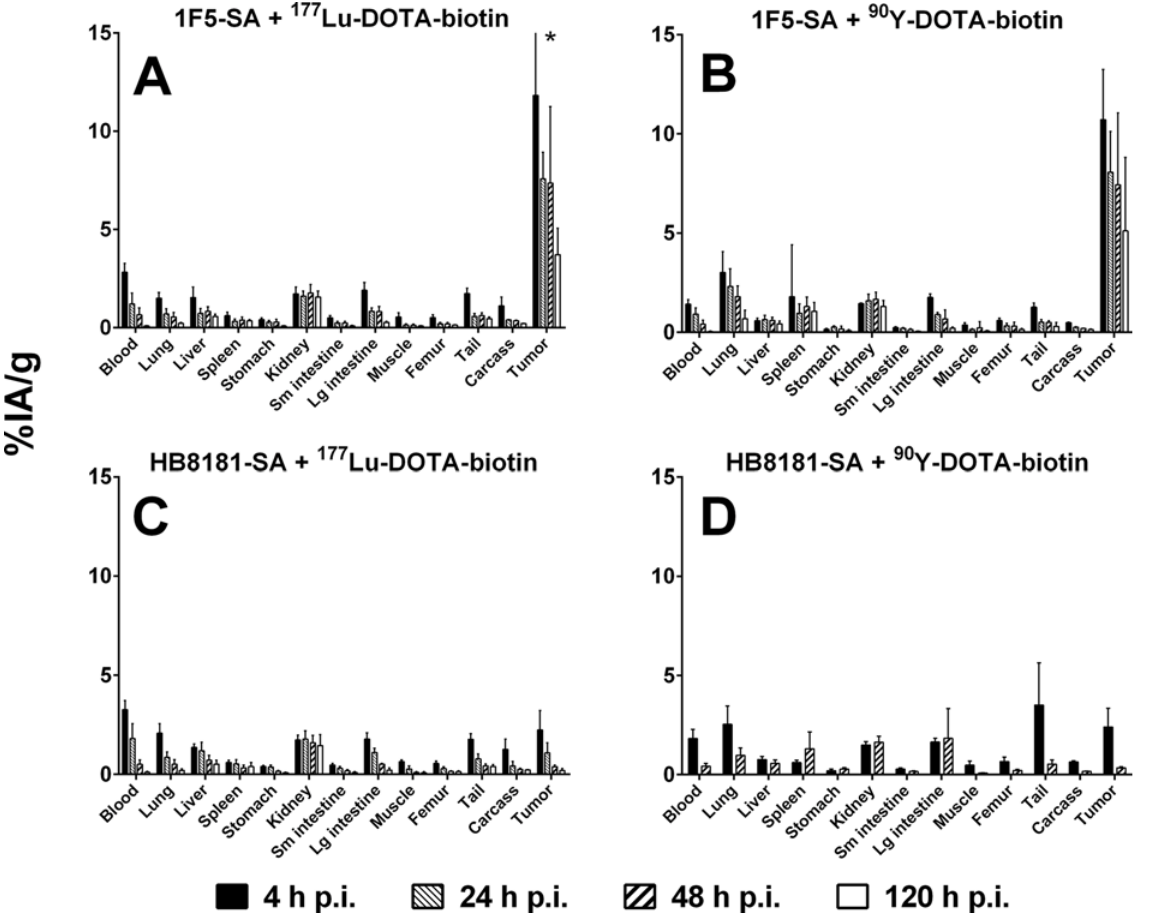
Fig 1. Comparative biodistributions of radioactivity in mice bearing subcutaneous Ramos xenografts. Mice were injected with 1.4 nmol 1F5-SA (A and B) or HB8181-SA (C and D), together with 400 μ g of HB8181. Circulating MAb-SA was cleared by administration of 5.8 nmol of NAGB 20 hours p.i. Four hours later, 2.4 nmol of either 177 Lu- (A and C) or 90 Y-labeled (B and D) DOTA-biotin was injected. Tissues were harvested 4, 24, 48, or 120 hours p.i. and the radioactive content expressed as %IA/g ( ± SD; n = 5) after corrections for decay and background. * Error bar extends to